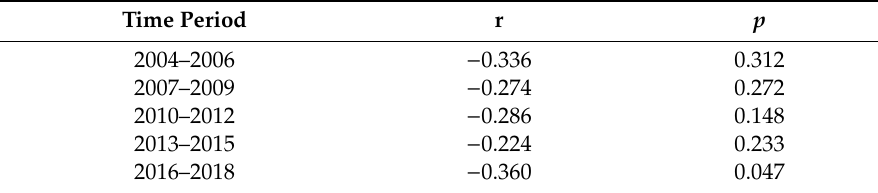
Table 1. Spearman’s correlation coe ffi cients between HB incidence and GDP from 2004 to 2018 (by 3 year period).